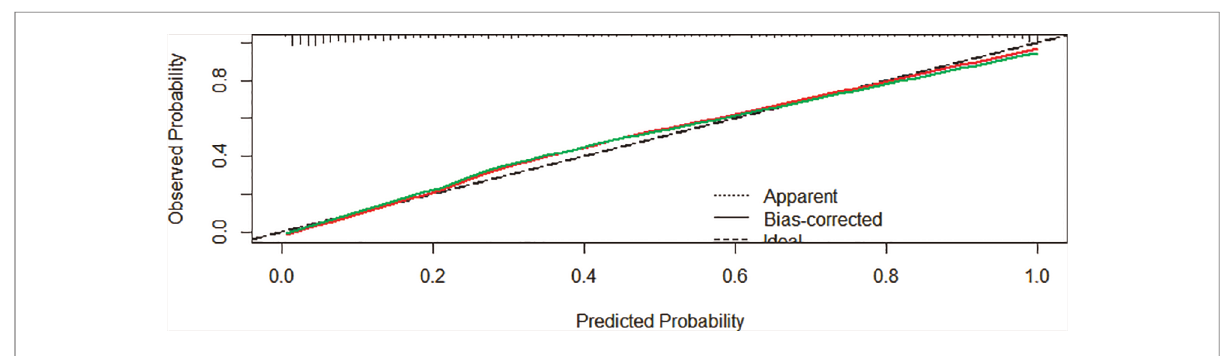
FIGURE 4 Calibration curves of the nomogram model in the training